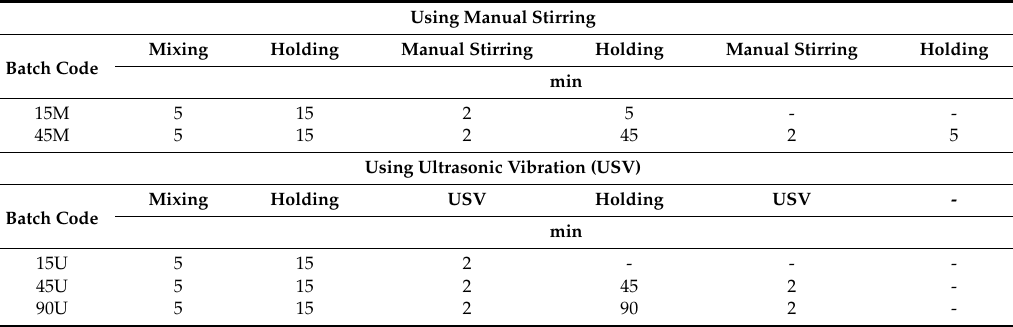
Table 2. Preparation parameters of the produced Al–Cu alloys.